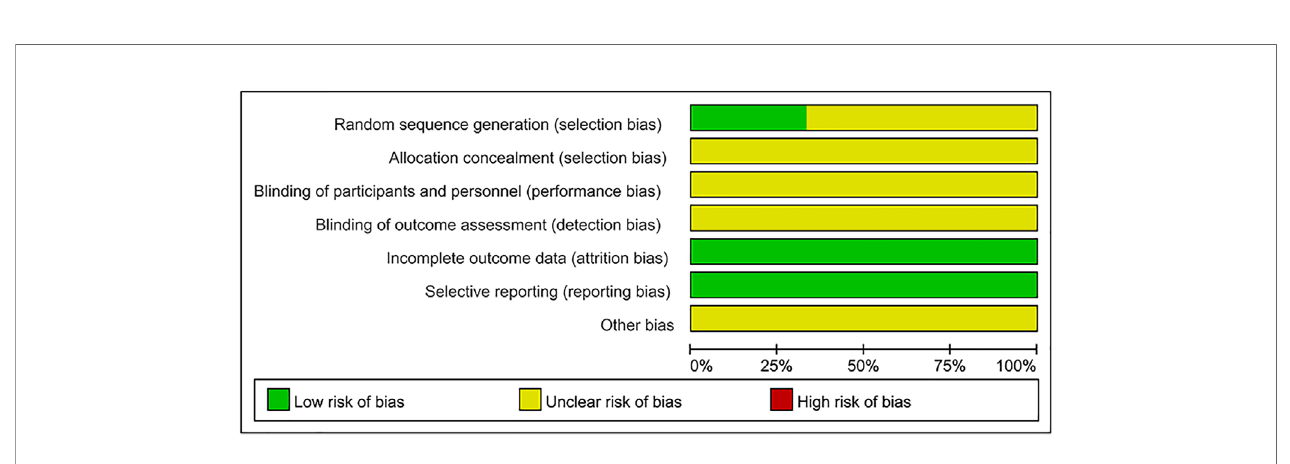
FIGURE 2 | Risk of bias graph.